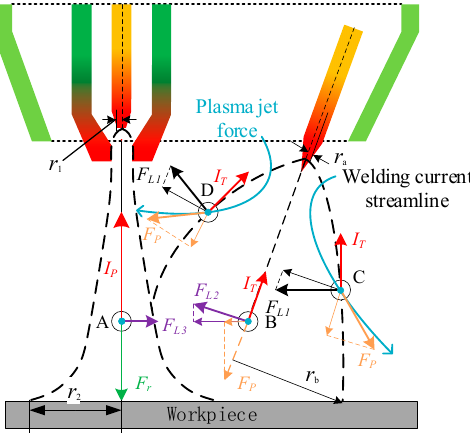
Figure 3. Schematic of the forces acting on the coupled arcs.